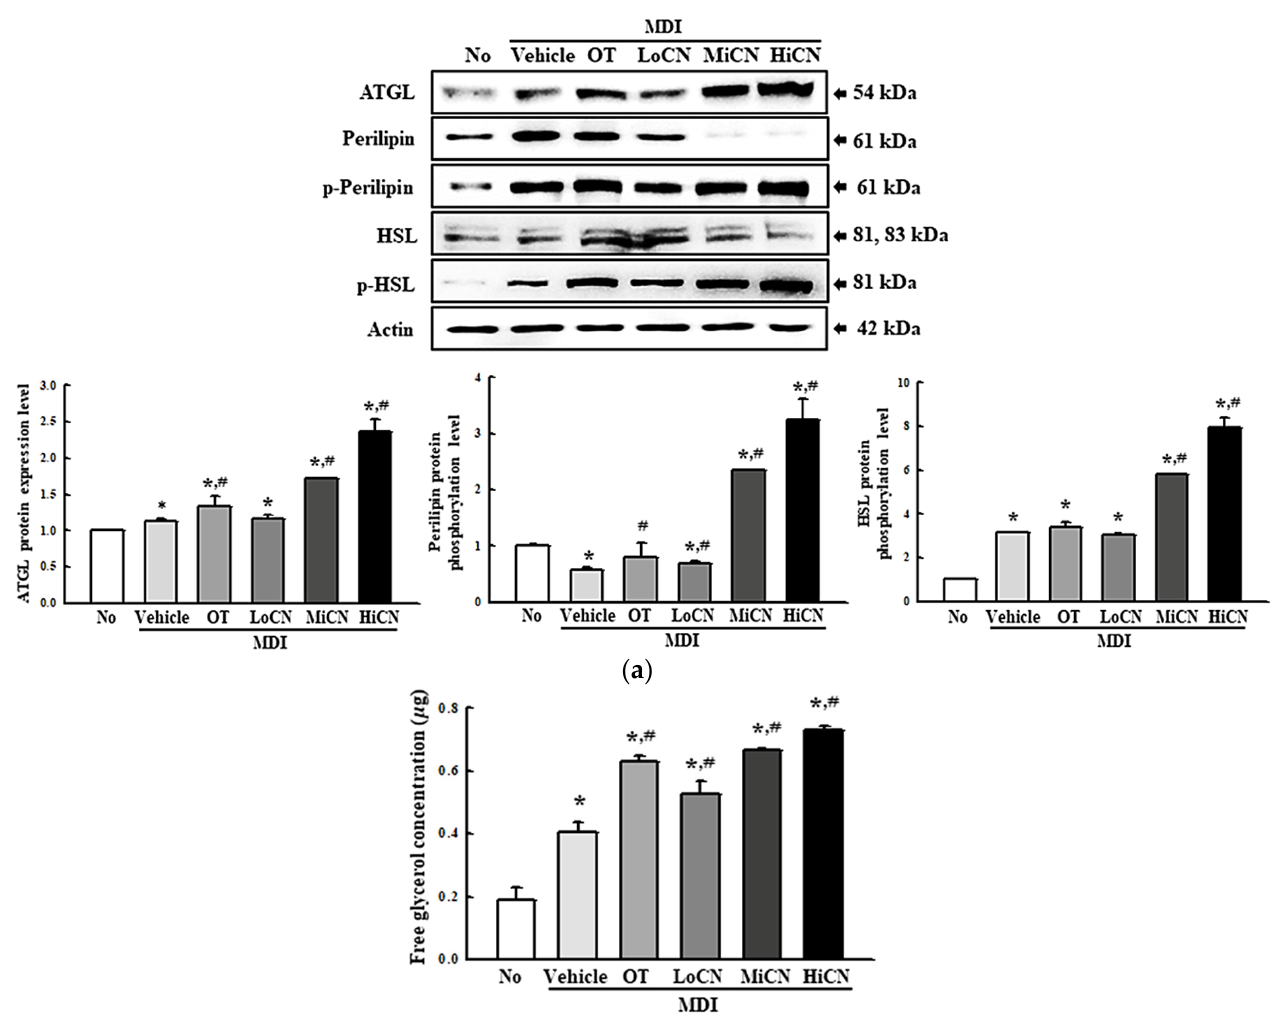
Figure 7. Expression of the lipolytic factors and the concentration of released free glycerol. ( a ) Expression level of the lipolytic proteins. After collecting the total proteins from the MDI-stimulated 3T3-L1 adipocytes treated with α -cubebenol, the expression level of ATGL, HSL, p -HSL, perilipin, p -perilipin, and β -actin were detected using the specific primary antibodies, followed by horseradish peroxidase (HRP)-conjugated goat anti-rabbit IgG. The intensity of each band was measured by an imaging densitometer, and the relative levels of each protein were calculated relative to the intensity of the actin bands. Two to three dishes per group were used to prepare the cell homogenates, and Western blot analysis was assayed in duplicate for each sample. ( b ) Level of free glycerol in culture media. The level of released glycerol was measured in the supernatant of the 3T3-L1 adipocytes treated with three different concentrations of α -cubebenol. Two to three wells per group were used for the assay, and the optical density was measured in duplicate. The data represent the means ± SD of three replicates. * indicates p < 0.05 compared to the No treated group. # indicates p < 0.05 compared to the MDI + Vehicle treated group. OT, orlistat; MDI, adipogenic cocktail consisting of 3-isobutyl-1-methylxanthine, dexamethasone, and insulin; LoCN, low concentration (7.5 μ g/mL) of α -cubebenol; MiCN, middle concentration (15 μ g/mL) of α -cubebenol; HiCN, high concentration (30 μ g/mL) of α -cubebenol.